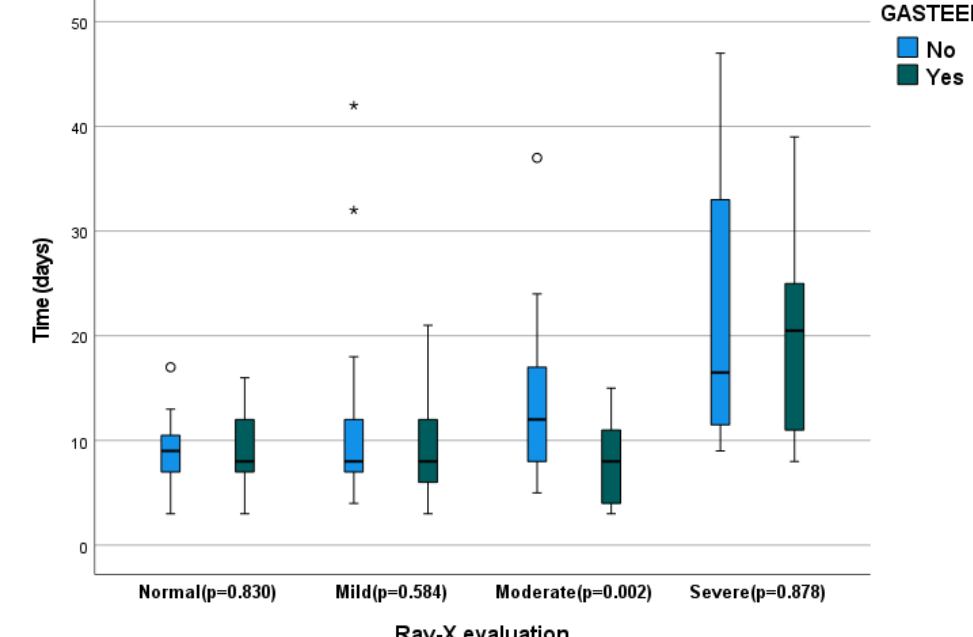
Figure 3. Duration of hospitalization (days) in the patient groups with normal, mild, moderate and severe chest X-ray on admission in the control and intervention groups. “°”Values greater than 1.5 times the interquartile range; “*”Values greater than 3 times the inter-quartile range.